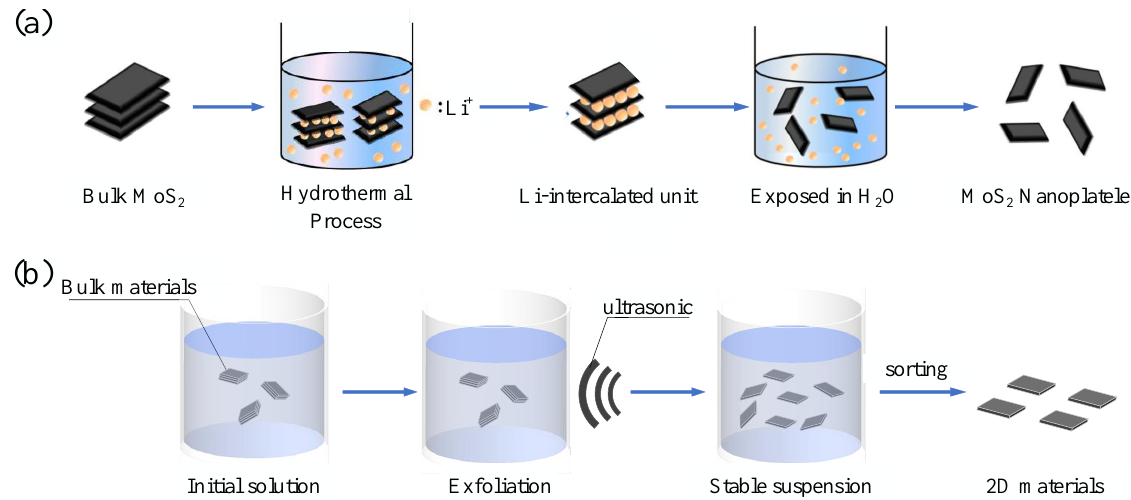
Figure 4. The preparation of 2D materials based on solution-processed methods. ( a ) Schematic of MoS 2 fabricated by hydrothermal intercalation/exfoliation. Adapted from [47]. ( b ) Schematic of 2D materials fabricated by liquid phase exfoliation (LPE)